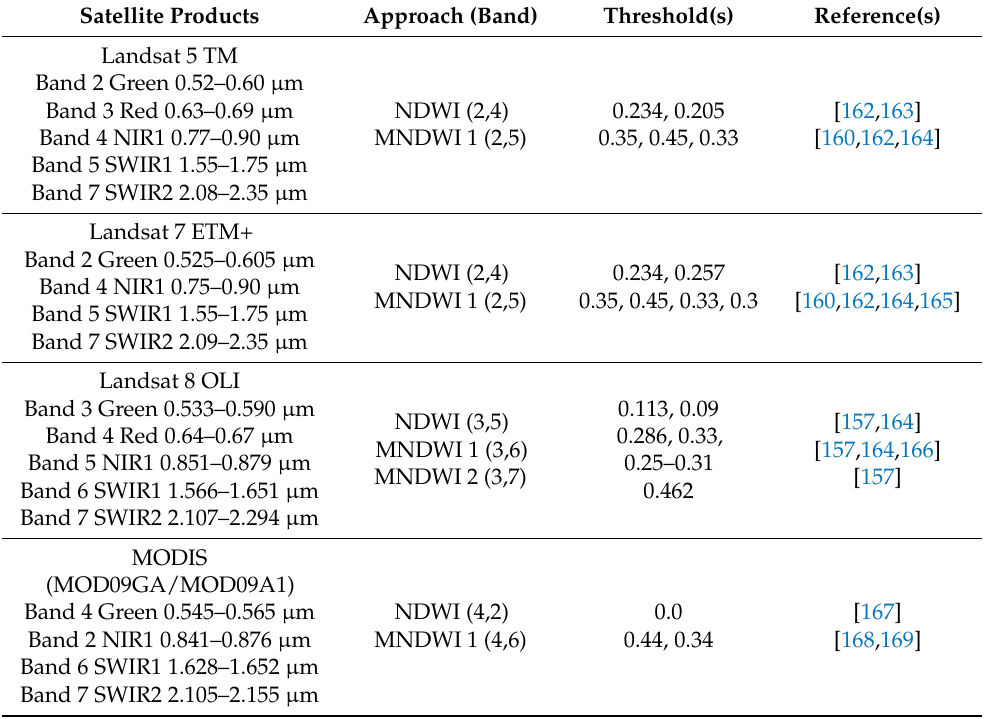
Table 1. Table 1. MODIS and Landsat information and thresholds of the NDWI, MNDWI 1, and MNDWI 2 used by